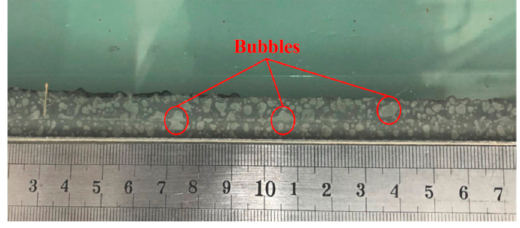
Figure 2. Bubbles in the sealing edge. Table 4. Evaluation basis for bubble size at the sealing edge.